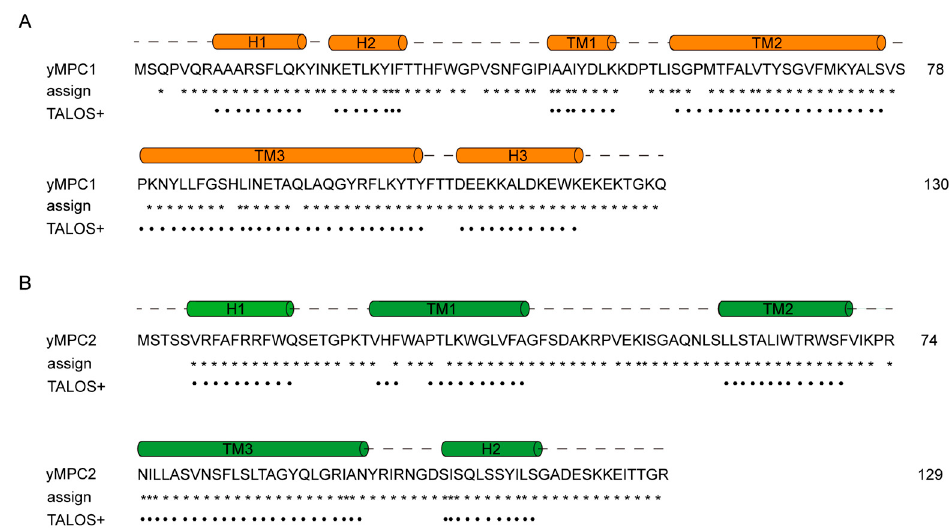
Figure 4. Secondary structures of yMPC1 and yMPC2 from TALOS + program. ( A ) Secondary structure of yMPC1 predicted based on TALOS+ analysis. The assigned residues are indicated as asterisks, and the helical regions predicted by the assigned chemical shift are indicated by black dots. ( B ) Secondary structure of yMPC2 predicted based on TALOS+ analysis. The assigned residues are indicated as asterisks, and the helical regions predicted by the assigned chemical shift are indicated by black dots.